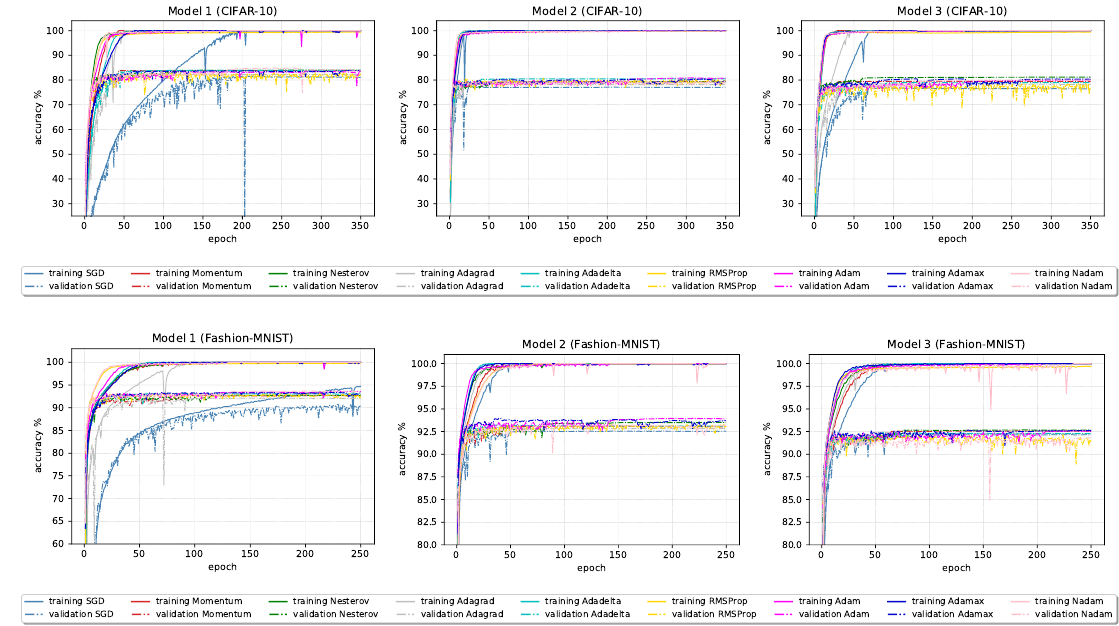
Figure 4. Accuracy learning curves for all optimizers on baseline